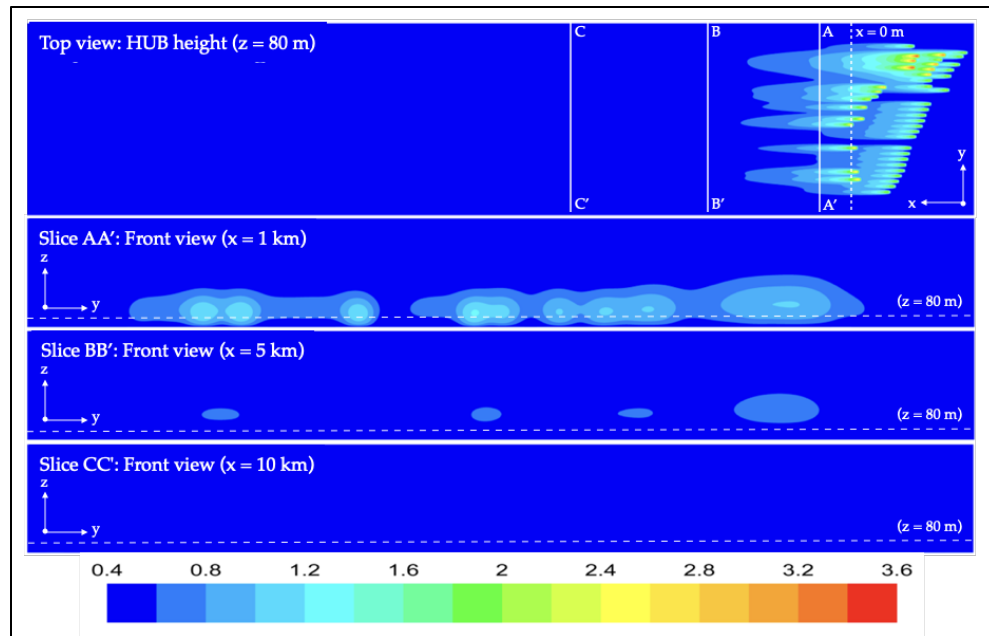
Figure 6. Turbulence kinetic energy k (m 2 /s 2 ) at hub height against the ambient turbulence kinetic energy at TI = 8%.